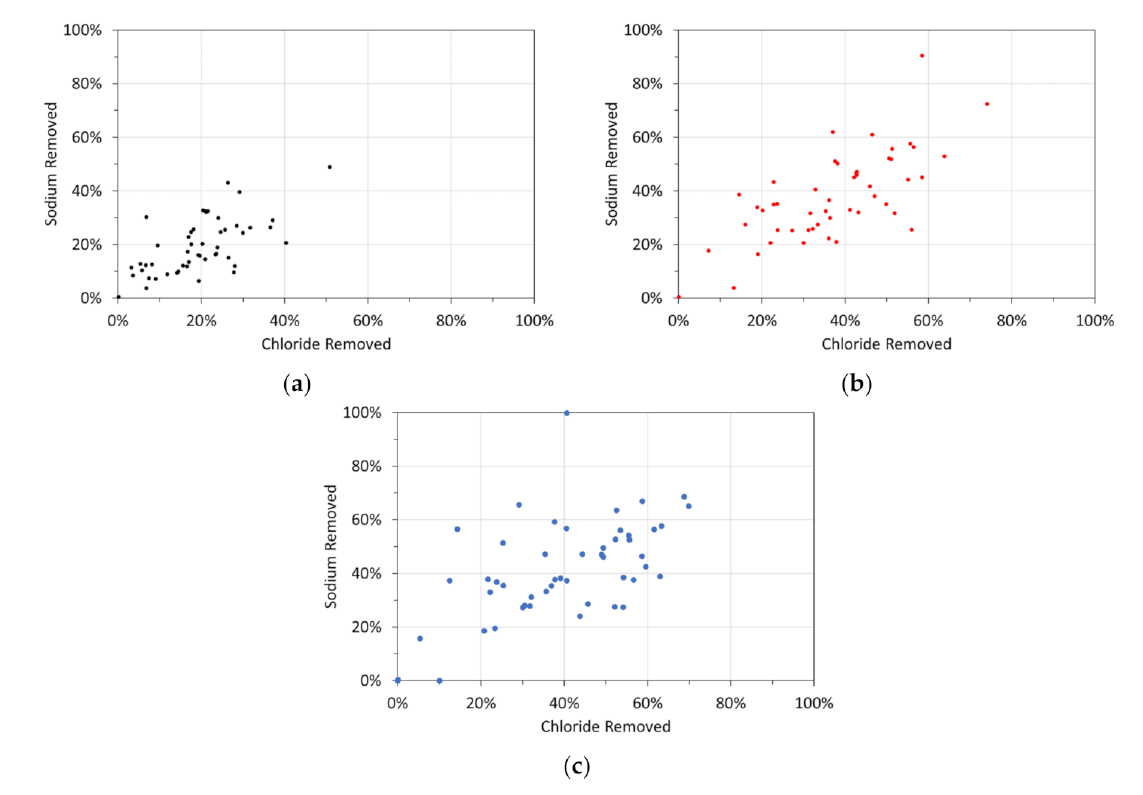
Figure A6. Relationship between ion removal and time spent in the reaction environment: ( a ) 3 h;